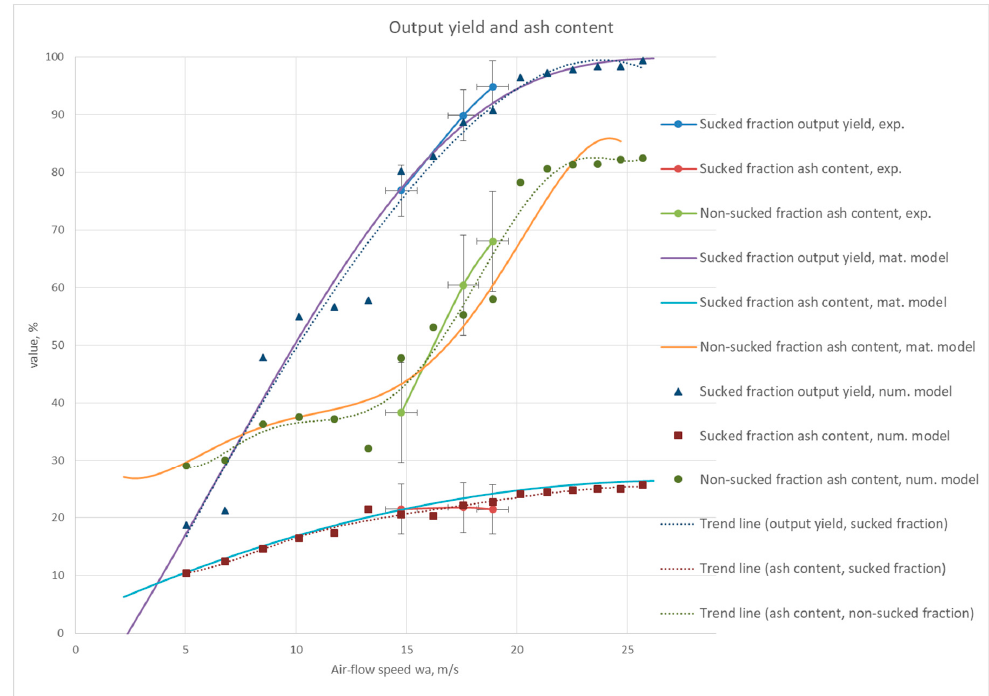
Figure 9. Comparison of values obtained experimentally and calculated using the developed models—output yield and ash content in relationship to air flow velocity; feed material no. 1 (0–20 mm).